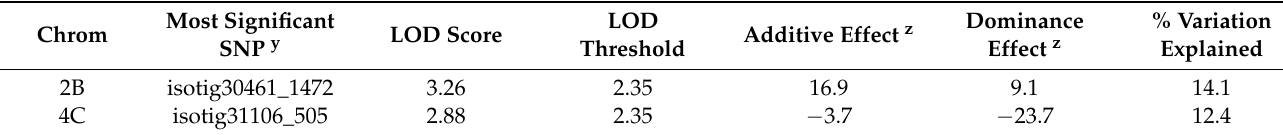
Table 5. Quantitative trait loci (QTLs) for resistance to Fusarium Basal Rot (FBR) in segregating F 4 families of onion, chromosome (Chrom), most significant single-nucleotide polymorphism (SNP), logarithm of odds (LOD) score and threshold at p = 0.05, additive and dominance effects, and percentage (%) phenotypic variation explained by